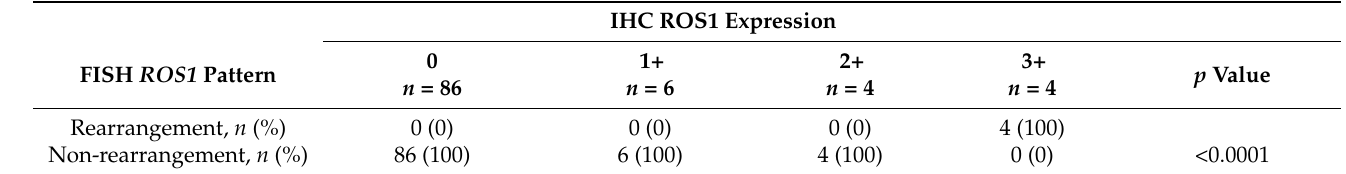
Figure 2. Grading of ROS1 protein overexpression by IHC staining. ( A ) A patient with a negative stain for ROS1 (0). ( B ) A case with weak cytoplasmic staining (1+) for ROS1. ( C ) A case with moderate (2+) cytoplasmic stain for ROS1. ( D ) A patient with strong (3+) granular cytoplasmic staining for ROS1. Table 3. Association of ROS1 expression with ROS1